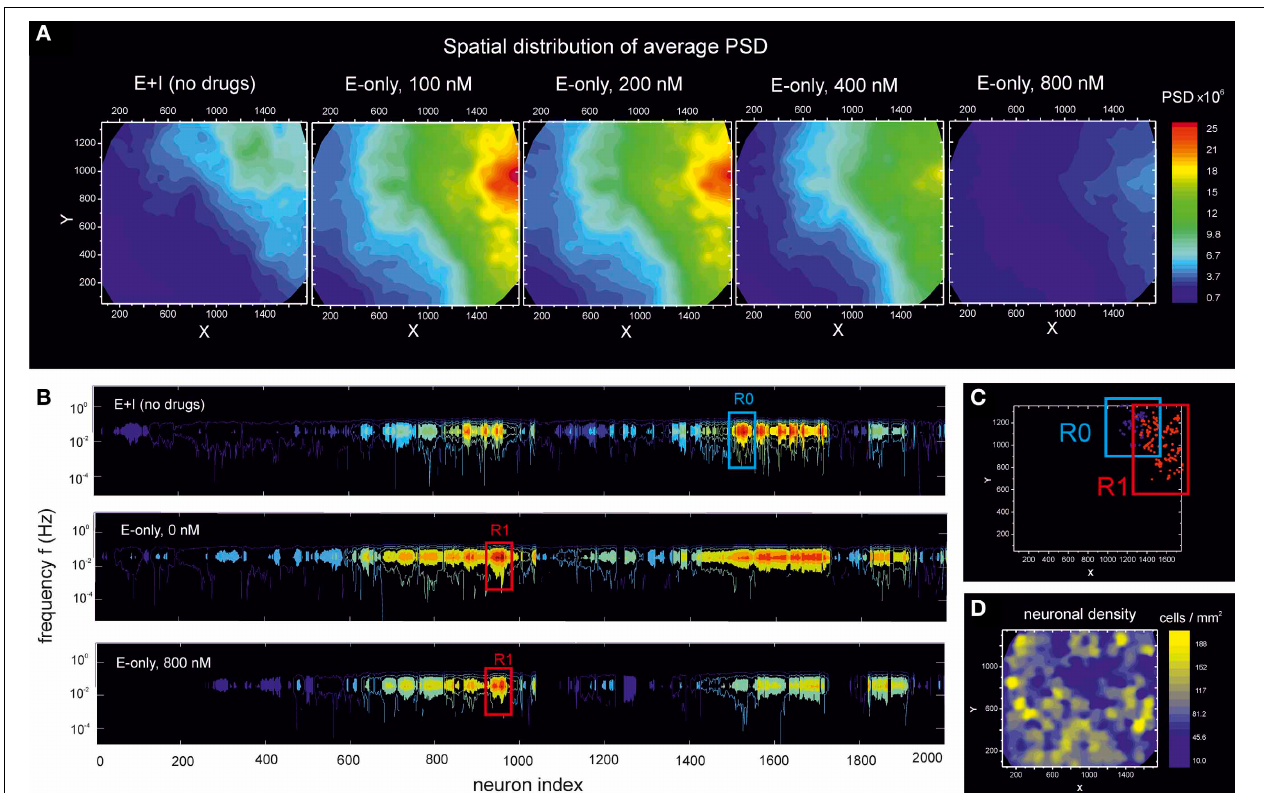
FIGURE 7 | Distribution of spectral energy across a culture during disintegration through CNQX. Data corresponds to the experiment at DIV 16 shown in Figure 6C . (A) For a given neuron, its PSD (averaged over frequencies) is displayed in the ( x , y ) space according to the spatial location of the neuron. The analysis is then extended to cover all the (cid:4) 2000 monitored neurons in the field of view, finally providing a color map of the PSD distribution across the network. For the unperturbed, “E + I” network, the neurons with the highest PSD form a compact spot in the top-right corner of the field of view. The blockade of inhibition both shifts and increases the size of this “highly energetic” group of neurons. This region progressively